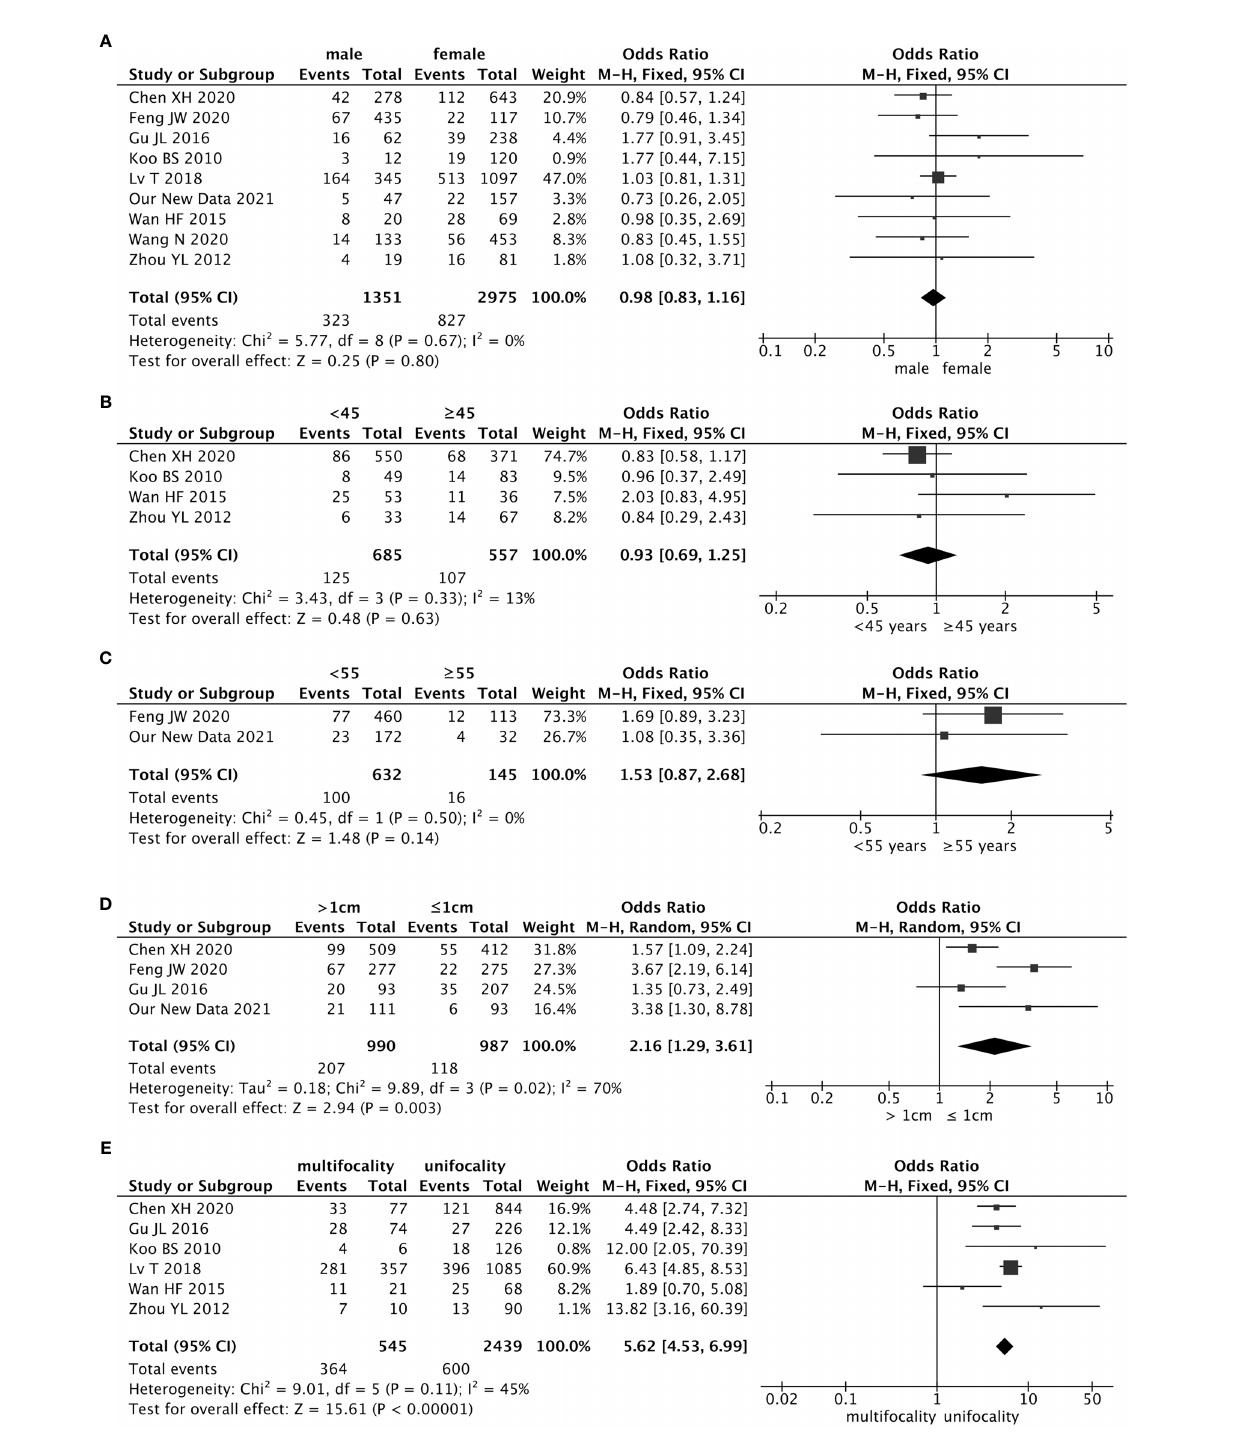
FIGURE 2 | Forest plots of the association between contralateral occult PTC (papillary thyroid carcinoma) and all risk factors: (A) Sex was not associated with contralateral occult PTC (pooled OR = 0.98, 95% CI = 0.83 – 1.16, p = 0.80); (B) The risk of age (cut-off value was 55) was not associated with contralateral occult PTC (pooled OR = 1.53, 95% CI = 0.87 – 2.68, p = 0.14); (C) The risk of age (cut-off value was 45) was not associated with contralateral occult PTC (pooled OR = 0.93, 95% CI = 0.69 – 1.25, p = 0.63); (D) The risk of contralateral occult PTC was signi fi cantly higher in patients with a tumor > 1 cm than patients with a tumor ≤ 1 cm (pooled OR = 2.16, 95% CI = 1.1.29 – 3.61, p = 0.003); (E) Compared with patients without ipsilateral multifocality, patients with ipsilateral multifocality had a higher prevalence of contralateral occult PTC (pooled OR = 5.62, 95% CI = 4.53 – 6.99, p <